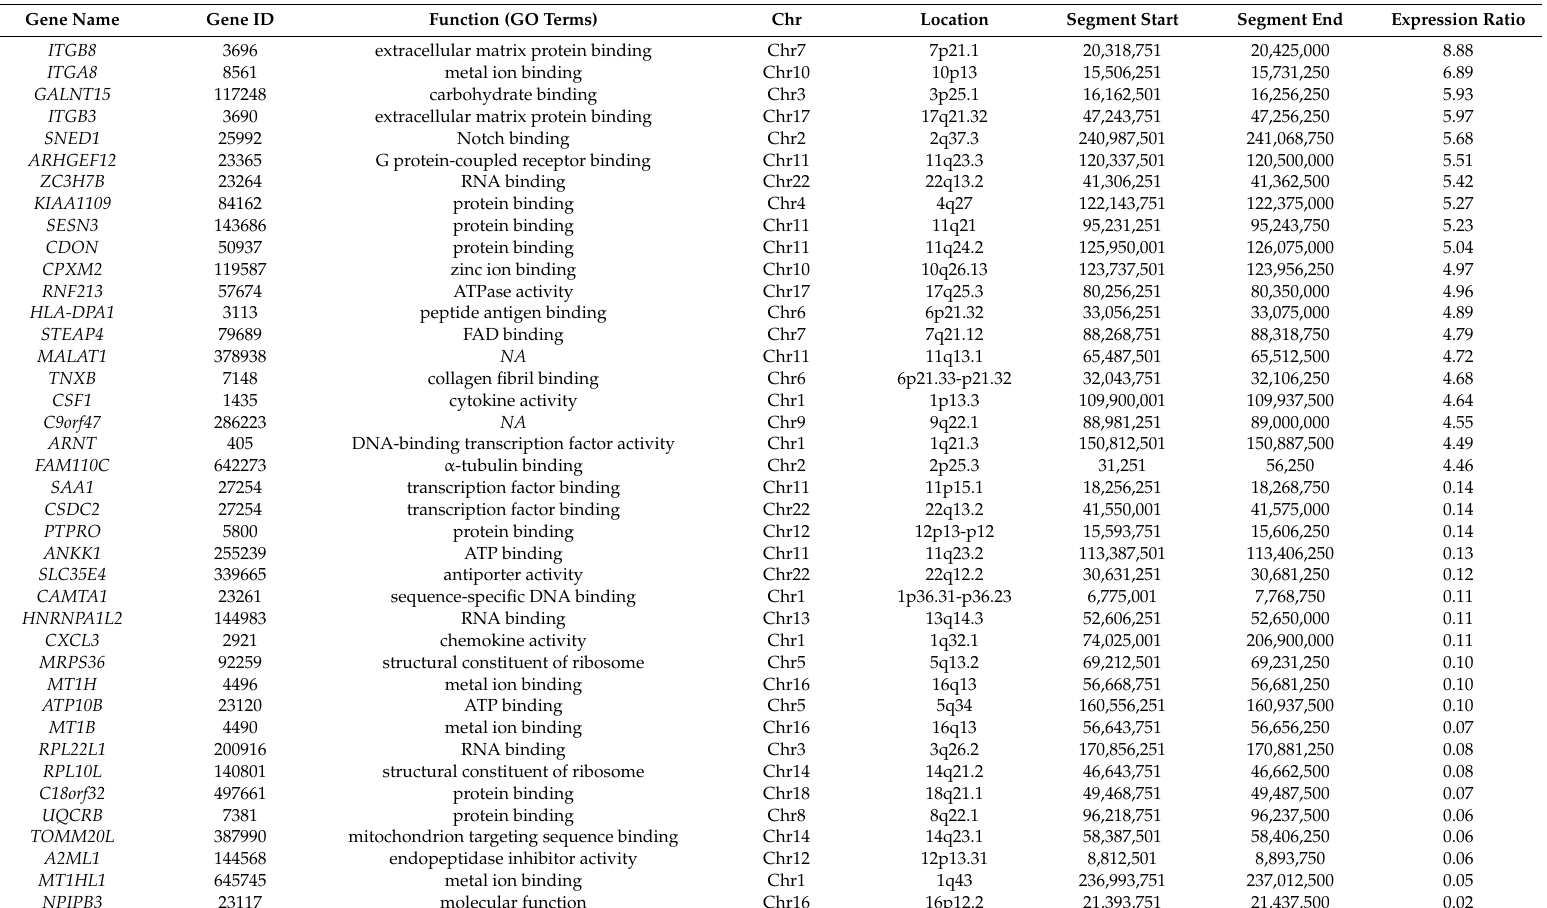
Table 3. List of the twenty genes significantly most over- or underexpressed (all significantly, with q < 0.05) in male vs. female hADSC